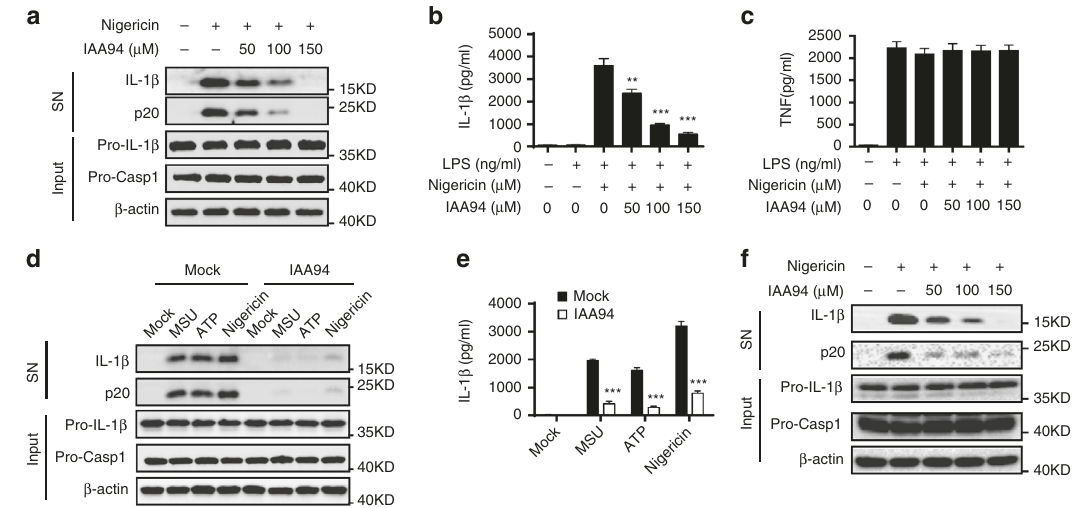
Fig. 1 IAA94 inhibits NLRP3 in fl ammasome activation. a Immunoblot analysis of IL-1 β and cleaved caspase-1 (p20) in culture supernatants (SN) of LPS-primed BMDMs treated with various doses ( above lanes ) of IAA94 and then left stimulated with nigericin, and immunoblot analysis of the precursors of IL-1 β (pro-IL-1 β ) and caspase-1 (pro-caspase-1) in lysates of those cells (Input). b , c ELISA of IL-1 β b and TNF c in supernatants from LPS-primed BMDMs treated with various doses of IAA94 and then stimulated with nigericin. d , e Immunoblot d or ELISA e analysis of IL-1 β and cleaved caspase-1 (p20) in culture supernatants of LPS-primed BMDMs treated with of IAA94 (150 μ M) and then left stimulated with MSU, nigericin, or ATP. f Immunoblot analysis of IL-1 β and cleaved caspase-1 (p20) in supernatants from PMA-differentiated THP-1 cells treated with various doses ( above lanes ) of IAA94 and then left stimulated with nigericin. Data are from three independent experiments with biological duplicates in each ( b , c , e ; mean ± SEM of n = 6) or are